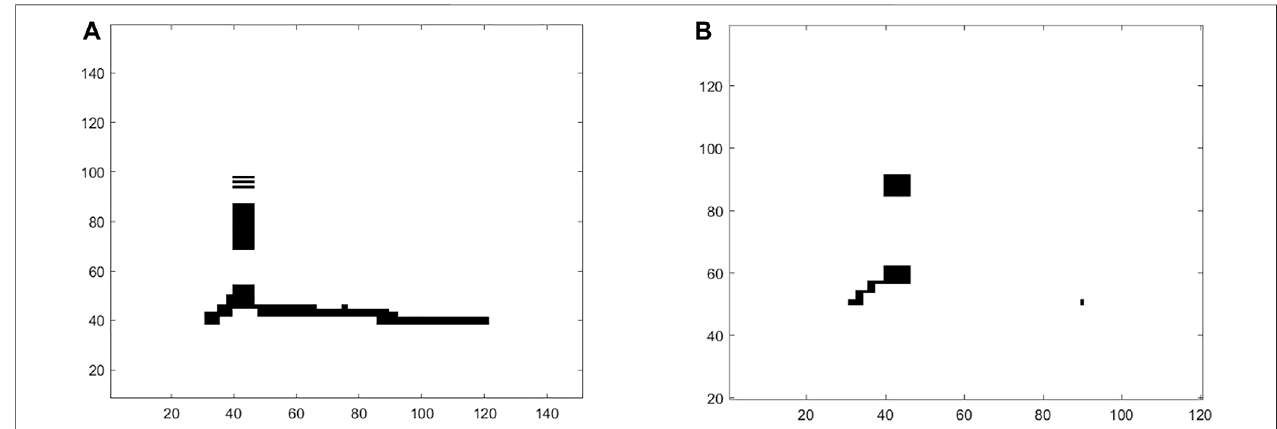
FIGURE 7 | Cross-Recurrence Plot of two different participants intentionally mimicking the facial expressions of anger displayed by the virtual agent (A) and the physical Furhat (B) .